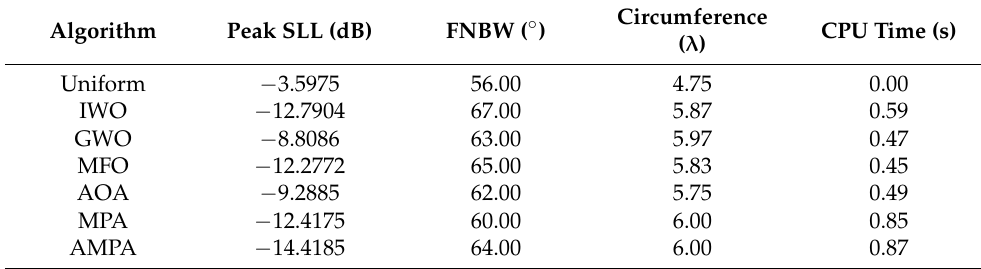
Figure 3. 8 − element CAA. ( a ) Radiation patterns obtained by different algorithms for reducing the PSLL. ( b ) Convergence rates of different algorithms for reducing the PSLL. Table 4. Optimization results of 10-element CAA obtained by different algorithms for peak sidelobe level (PSLL)